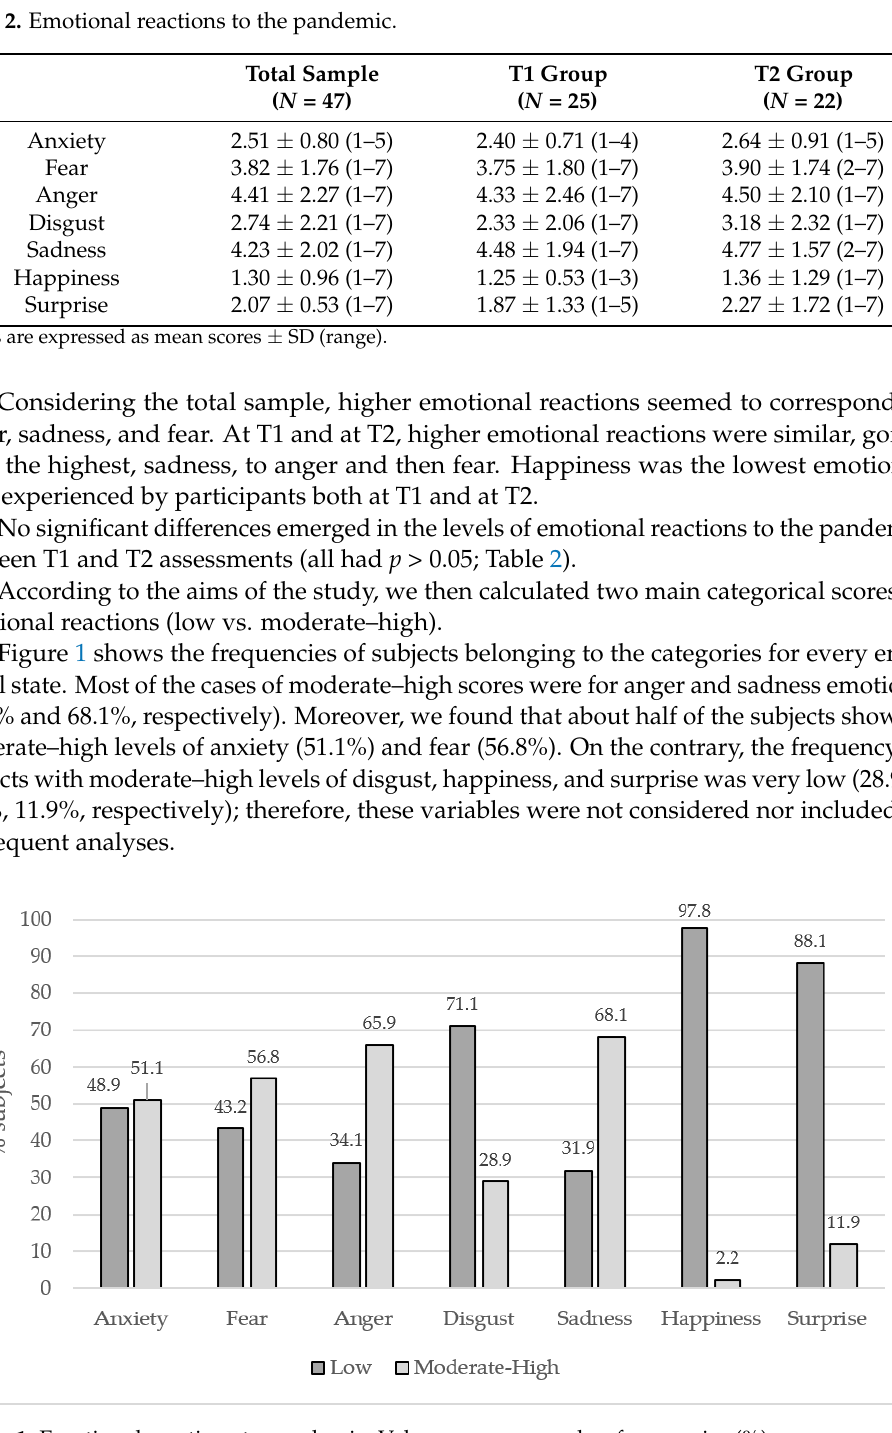
Figure 1. Emotional reactions to pandemic. Values are expressed as frequencies (%).